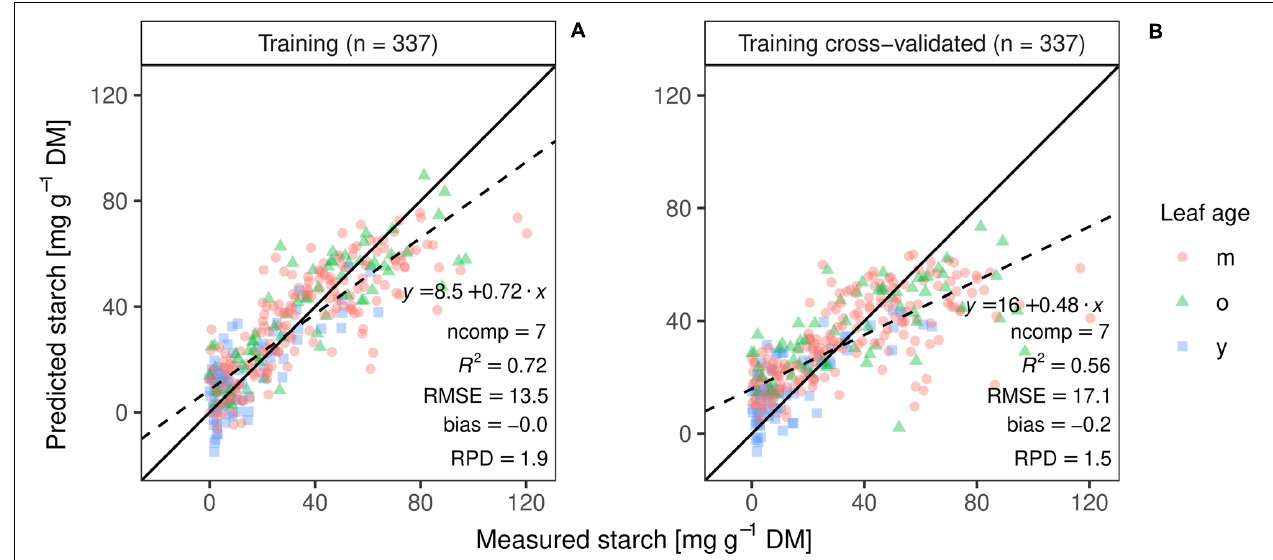
FIGURE 7 | PLS regression of the training set (A) and best model performance of the cross-validation on the same set ( B ; ncomp = 9; n = 337) Different colors and shapes indicate the age of the leaves, m for matures leaves, o for the oldest leaf, and y for the youngest fully emerged leaf. Regression line (dashed line), 1:1 line (solid black line) and summary statistics are shown.